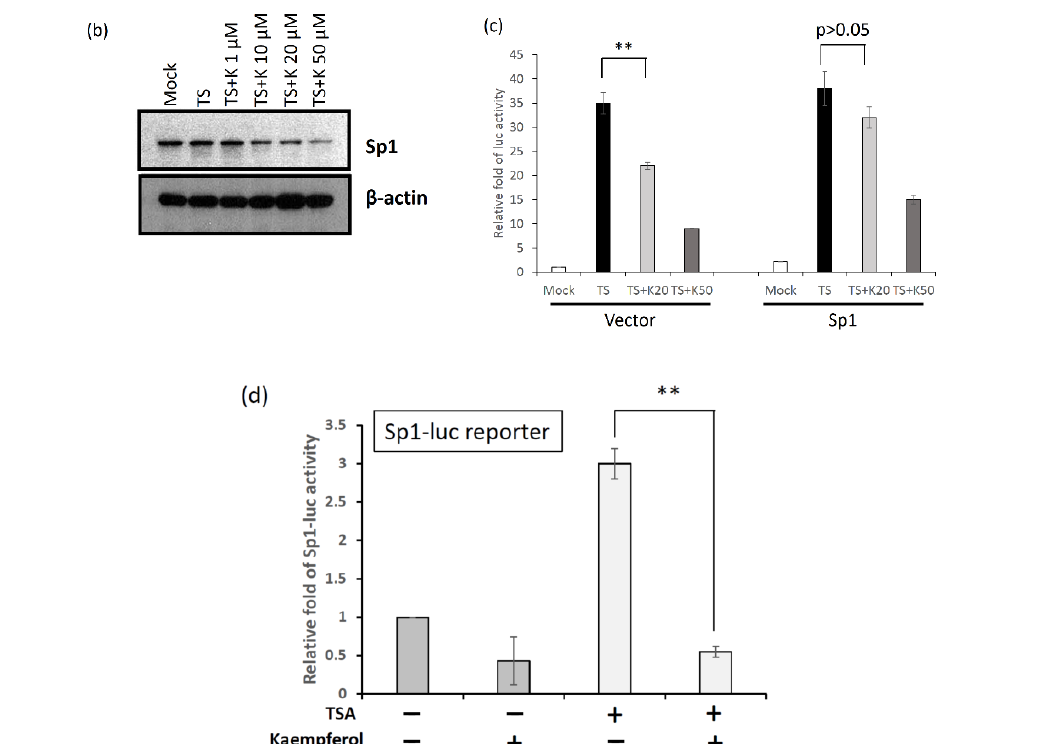
Figure 7. Sp1 binding domains on Zp are important for kaempferol inhibition in NPC cell lines. ( a ) NA cells treated with TPA + SB and kaempferol were transfected with the wild type Zp and its mutants harboring putative Sp1 binding sites located on Z1A, Z1B, Z1C and Z1D domains. The corresponding mutation sites were shown as a black triangle ( ▲ ) in the left diagram. The mutant with ZIIIA mutations was a positive control. ( b ) NA cells were treated with kaempferol and TPA + SB for 24 h. The cell lysates were detected for Sp1 expression. The β -actin expression was the loading control. ( c ) NA cells were firstly co-transfected with vector or Sp1-expressing plasmid and Zp reporter for 3 h, respectively. After transfection, the cells were pretreated with kaempferol and TPA + SB. After 24 h treatment, the luciferase activities of Zp were detected. ( d ) The luciferase reporter with Sp1 promoter was transfected into TW01 cells under indicated conditions: mock, kaempferol, TSA, or TSA + kaempferol treatments for 24 h. The cell lysate was detected for luciferase activities. The values of each sample were derived from three independent trials. (** p < 0.01) The relative fold of luc or Sp1-luc activity was represented as the relative fold of luciferase activity compared to mock control. TS:TPA + SB; K20 and K50: 20 and 50 µ M